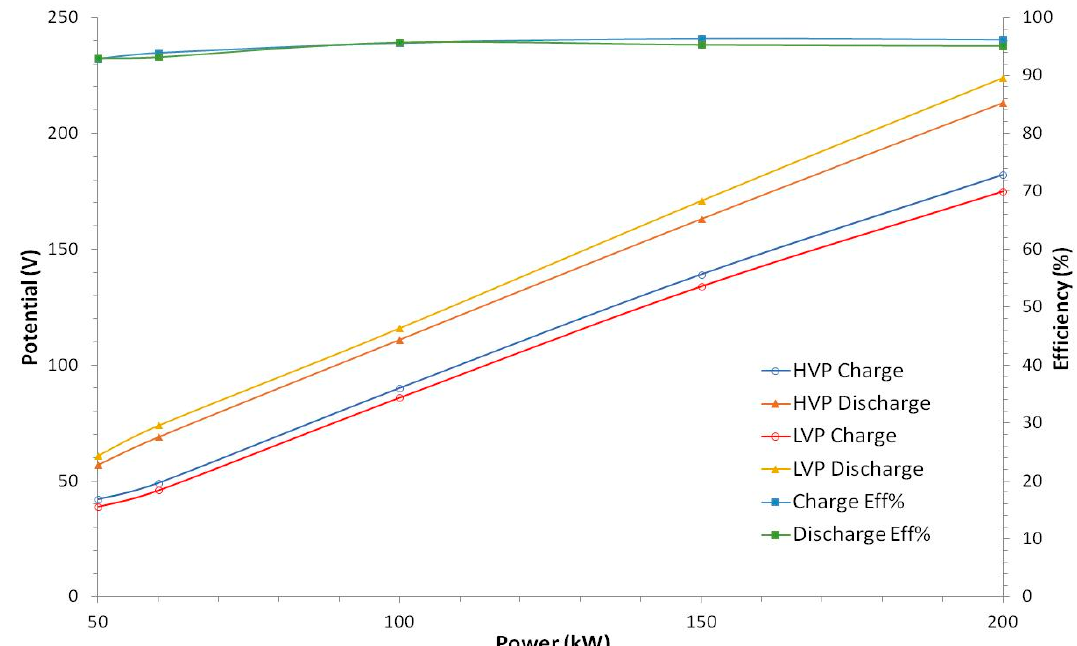
Figure 7. High voltage potential (HVP) and low voltage potential (LVP) values and DC/DC conversion efficiencies as a function of operating power.